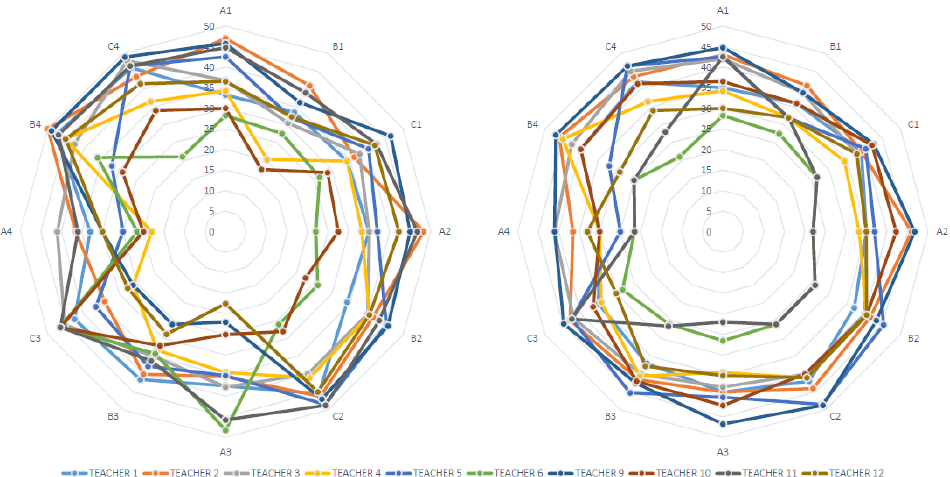
Figure 14. Teachers’ sound distribution measurements before (on the left) and after (on the right) feedback .